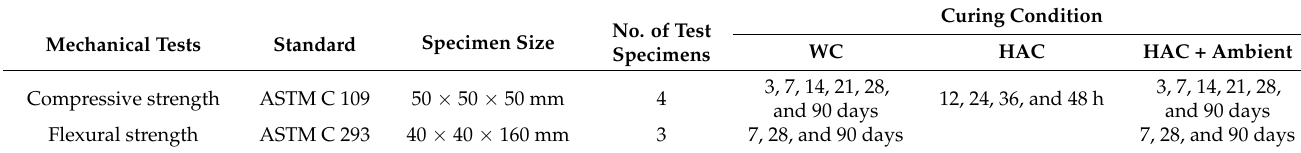
Table 3. Summary of mechanical tests